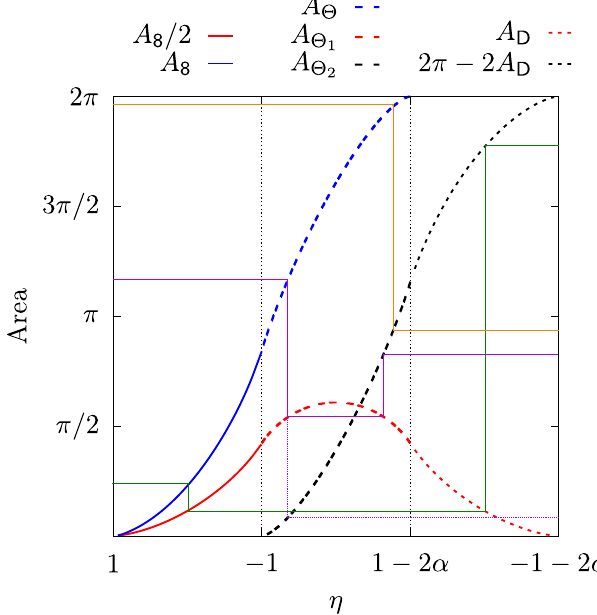
FIG. 6. Scheme of the trapping process in the case α > 1 . Thick lines represent the areas of the different phase-space regions as a function of η (note the reversed horizontal scale, as we describe a process in which η decreases with time). The same color represents a continuity of a region throughout the intervals 1 > η > − 1 , − 1 > η > 1 − 2 α , 1 − 2 α > η > − 1 − 2 α . Thin lines show the evolution of the area with three possible initial conditions. The green line represents a particle that is first trapped in A 8 and then released from A D . The purple line shows (with a bifurcation) the two possible outcomes of a particle trapped either in A Θ and then released, or in A Θ at η (cid:4) > − 1 − α . Finally, the 1 2 orange line represents a particle trapped in A Θ when 1 η (cid:4) < − 1 − α